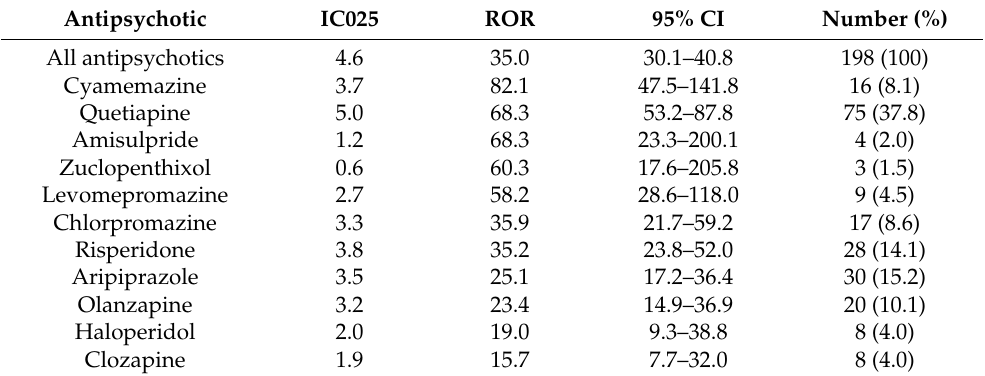
Table 2. Disproportionality analysis for reports of abuse, dependence, or withdrawal in patients aged between 0 days and 23 months, ranked by ROR.